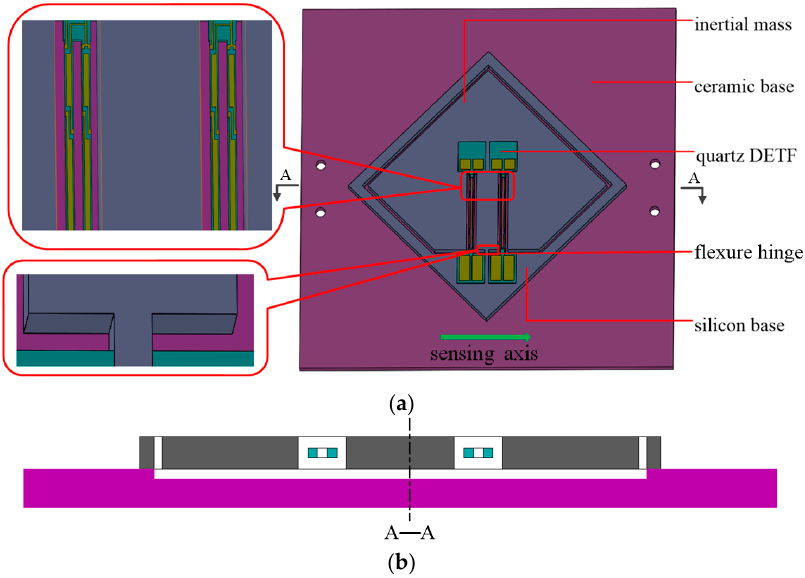
Figure 7. ( a ) Diagrammatic sketch of the resonance sensor; and ( b ) cross-sectional view along A-A.